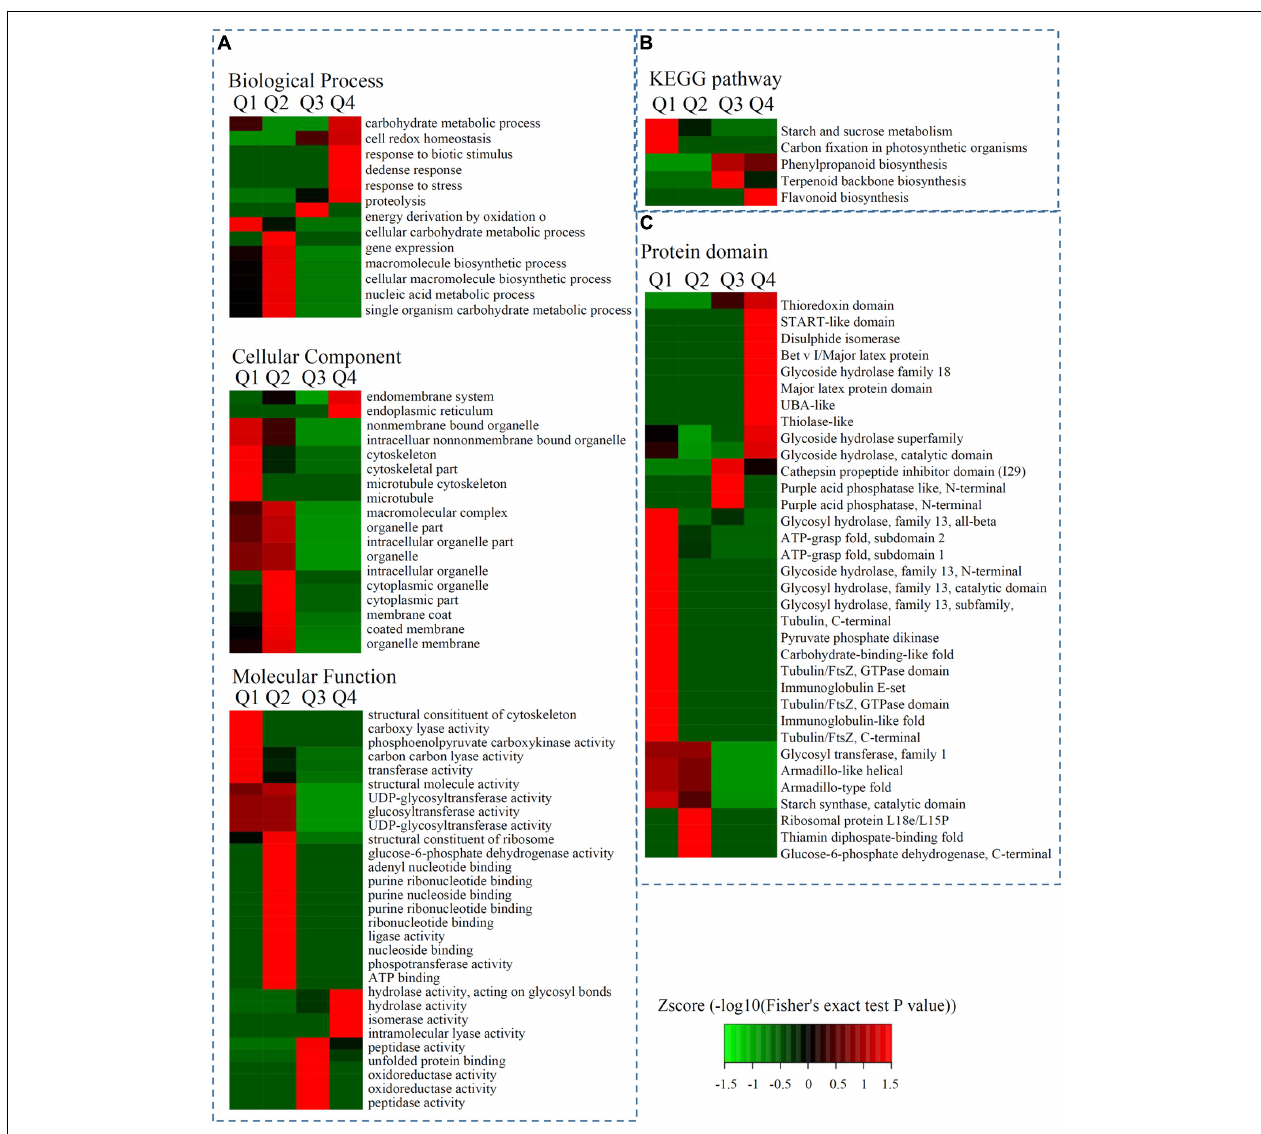
FIGURE 3 | Enrichment analysis of DEPs in hickory during grafting process. (A) Significantly enriched GO terms of DEPs concerning cellular component, molecular function and biological process. (B) Significantly enriched KEGG terms of DEPs. (C) Significantly enriched protein domains of